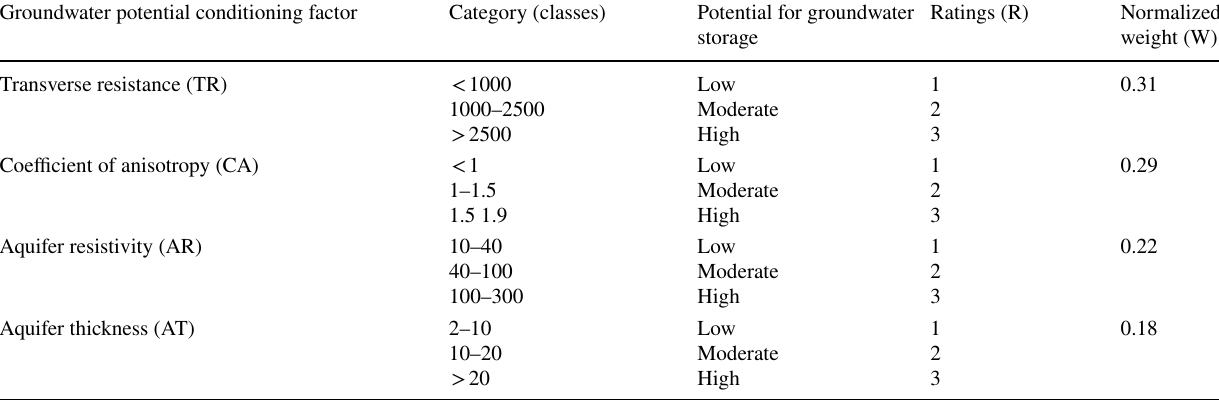
Fig. 3 Topological map showing the VES and borehole points Table 1 Probability rating (R) for classes of the parameters (modified after Mogaji and Omobude